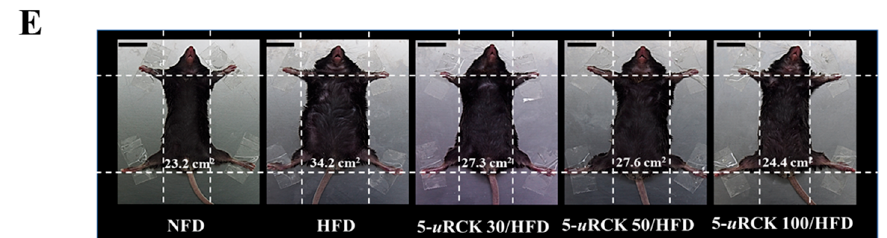
Figure 4. E ff ects of 5- u RCK on body weight changes, liver weight, and epididymal adipose tissue weight in HFD-induced obese mice. ( A ) Body weight was monitored three times per week for 8 weeks. ( B ) Body weight gain was measured from the 3rd week until the 8th week. ( C ) The weight of total liver tissue. ( D ) The weight of the epididymal fat pad; ( E ) Phenotype of representative mice from each group. The body width of each group of mice was checked before sacrifice. The scale bars indicate 20 mm. The results are presented as the mean ± SD (n = 8). * p < 0.05, ** p < 0.01 and *** p < 0.001 vs. NFD group; # p < 0.05 and ### p < 0.001 vs. HFD group.